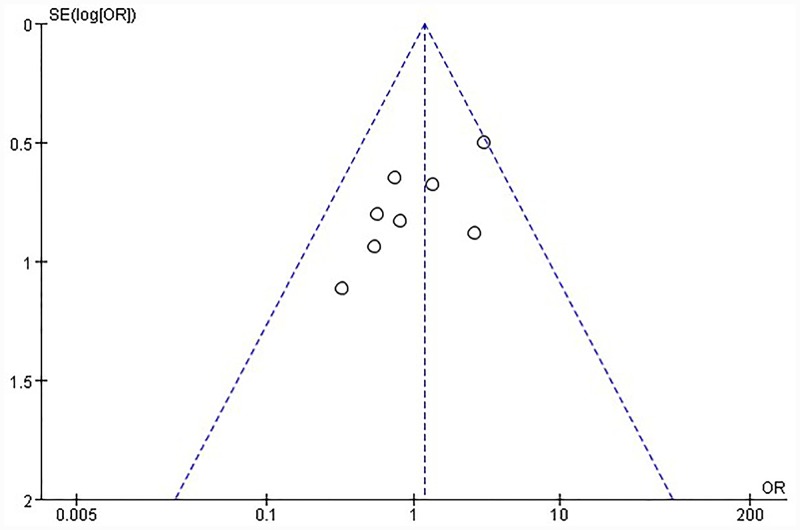
Funnel plot of the estimates for Gd-EOB-DTPA-enhanced MRI in HCC diagnosis.(A) sensitivity analysis. (B) specificity analysis. (C) positive likelihood ratio analysis. (D) negative likelihood ratio analysis.